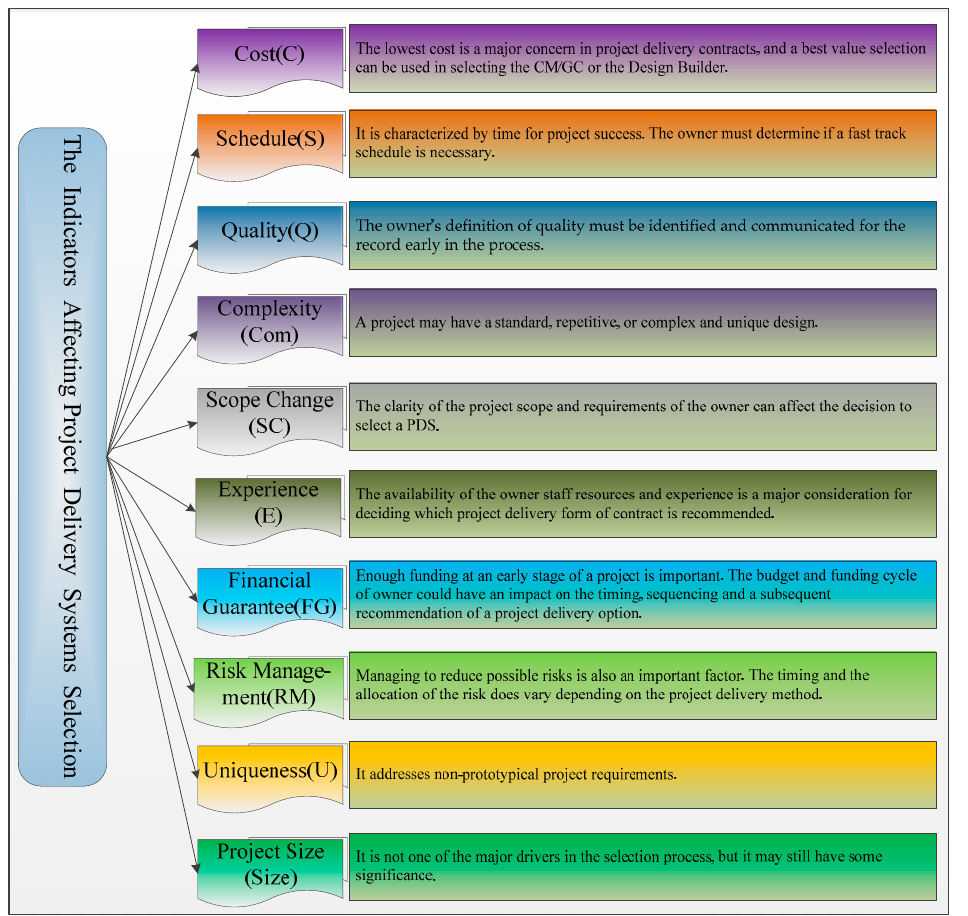
Figure 1. The indicators affecting project delivery systems (PDSs) selection.